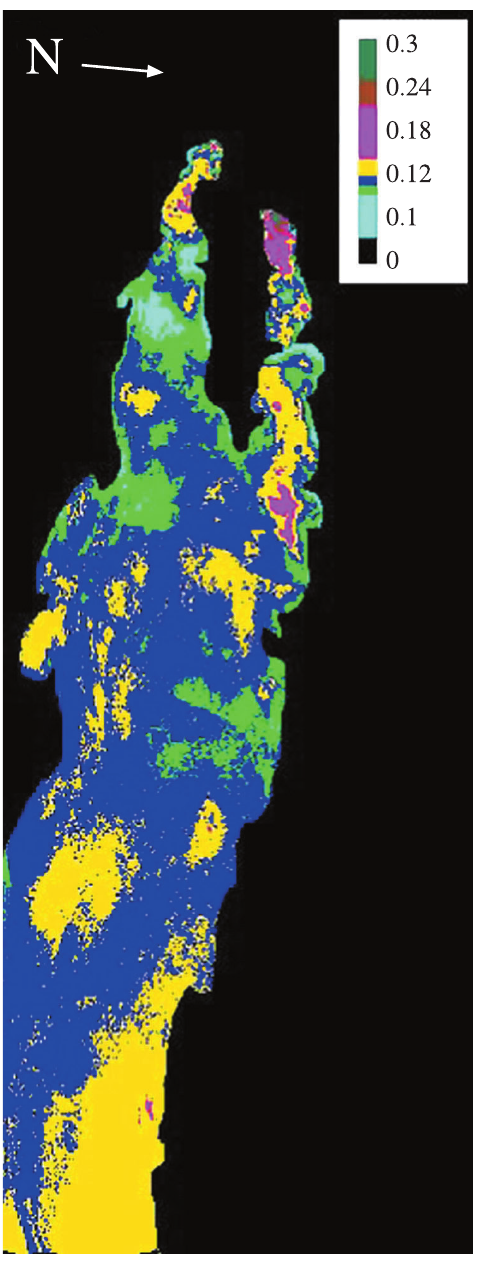
Fig. 5. Resulting map of volcanic plume aerosol optical thickness ( t a ) in false colours. Average value of spatial distribution t a =